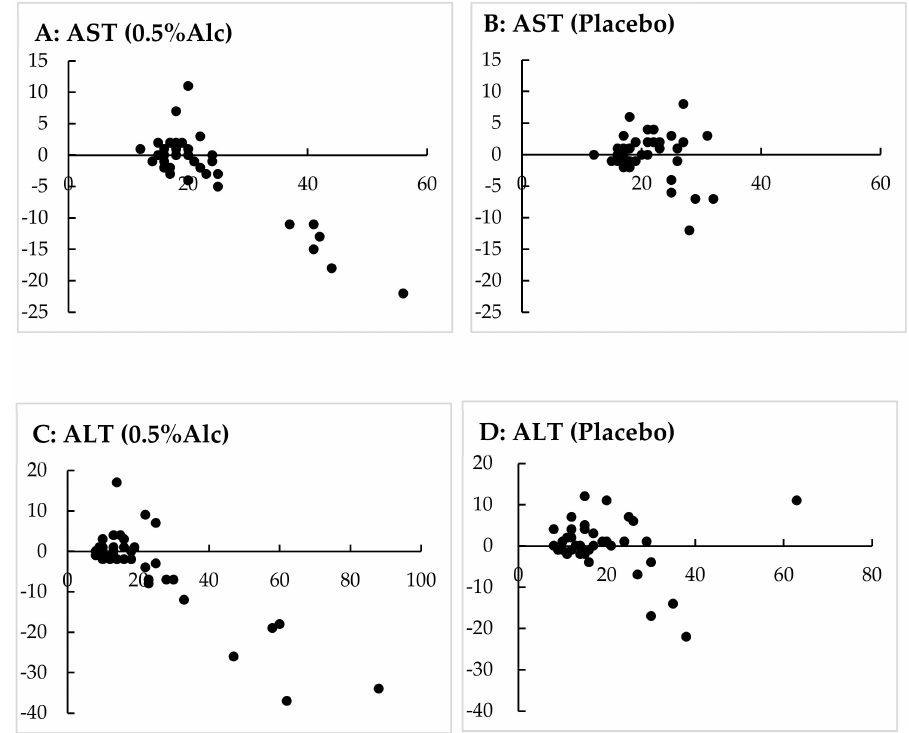
Figure 2. Relationships between the baseline levels and varying amounts of serum AST and ALT. The X-axis shows the baseline serum AST or ALT concentration (units per liter), whereas the Y-axis shows the varying amounts of serum AST or ALT concentration (units per liter) from baseline to 4 weeks later. ( A ) Serum AST levels of the 0.5%Alc group. ( B ) Serum AST levels of the placebo group. ( C ) Serum ALT levels of the 0.5%Alc group. ( D ) Serum ALT levels of the placebo group ( n = 41). AST, aspartic aminotransferase; ALT, alanine aminotransferase.